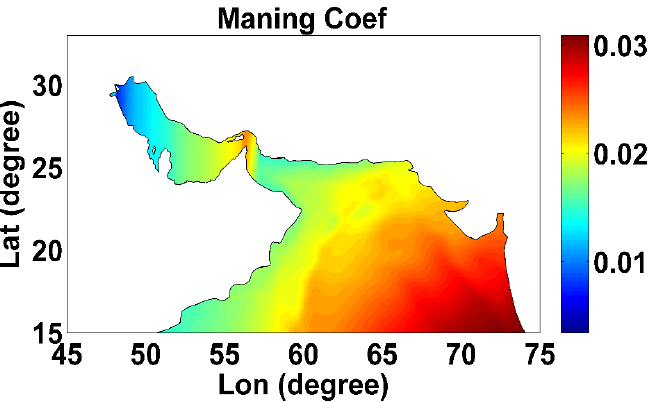
Figure 11. Optimum Manning coefficient in the study area.